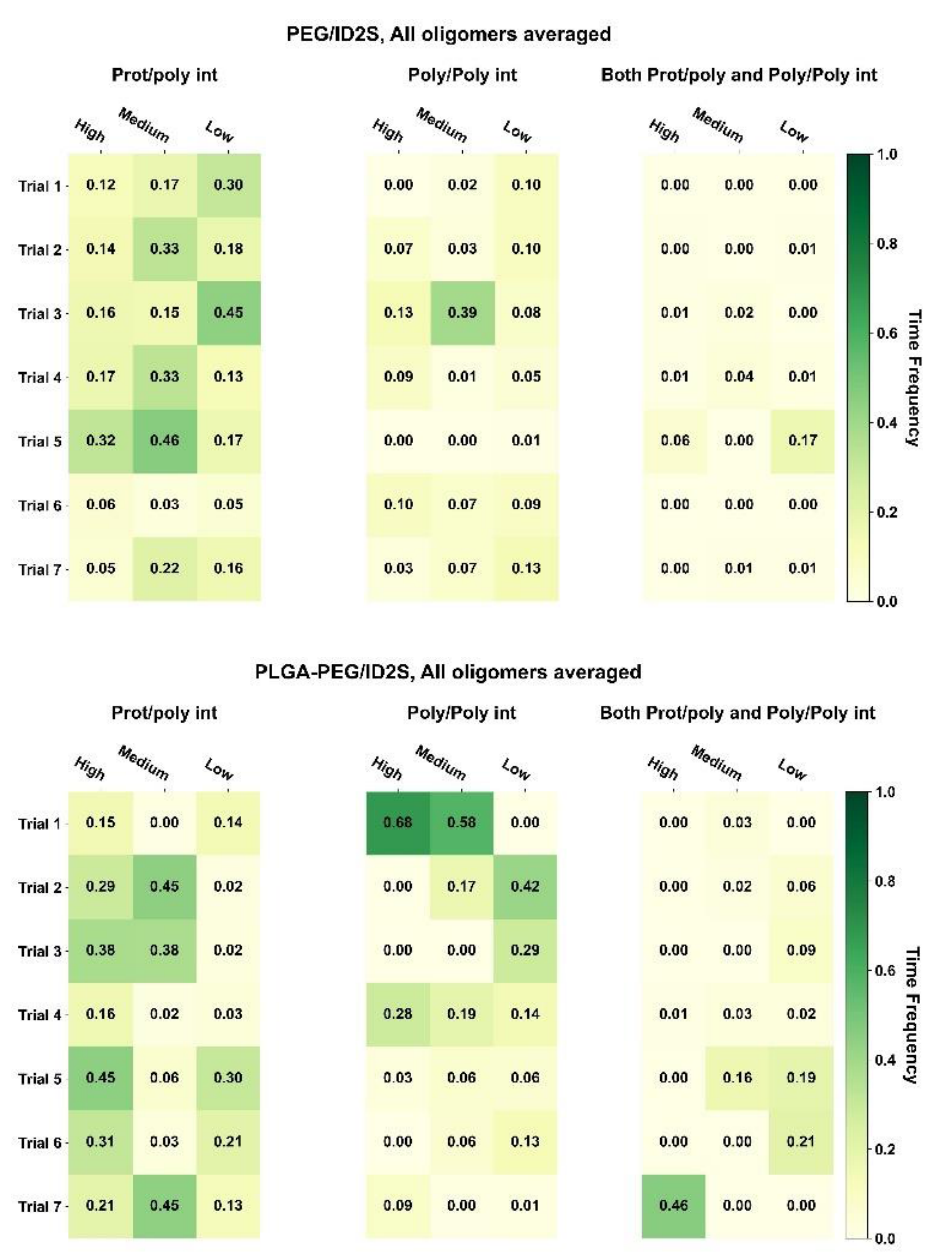
Figure A7. Oligomer-averaged time frequency of each interaction class, for each simulation trial across the different polymer types. Both restraint-on and -off phases were accounted for in the calculation of TF. These mean values were used to calculate TF poly avg , as seen in the Results and Discussion section.